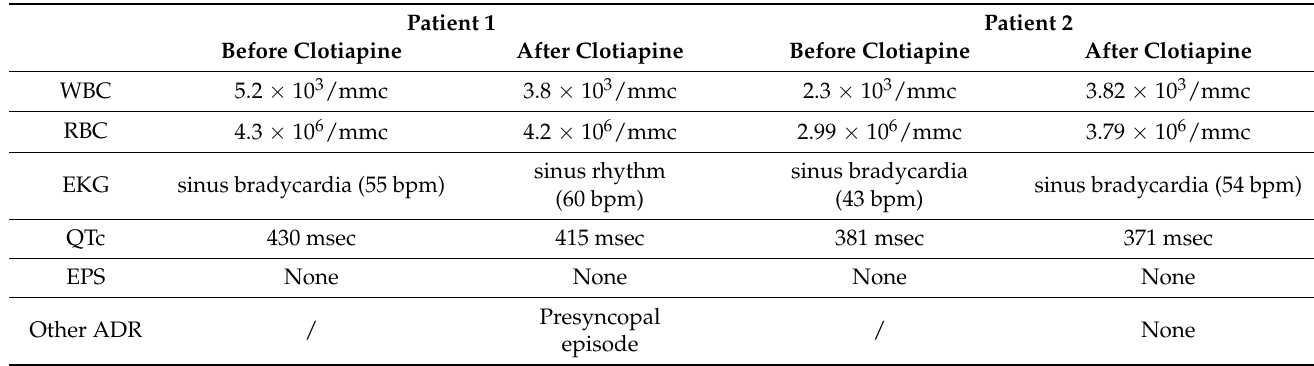
Table 1. Laboratory and cardiological parameters before and after the introduction of clotiapine for the two patients. Patient 1 Patient 2 Before Clotiapine After Clotiapine Before Clotiapine After